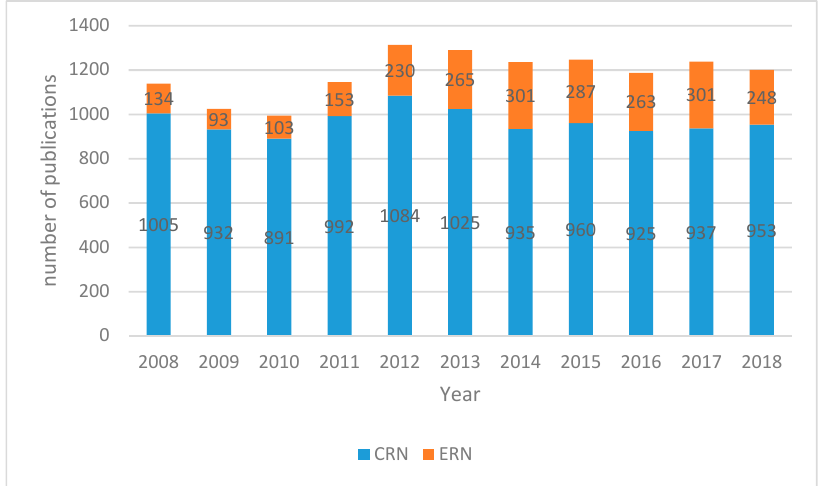
Figure 1. A comparison between the annual publication number of CRNs vs. ERNs (2008–2018). Total number of papers = 12717; total number of papers on CRNs = 10339; total number of papers on ERNs = 2378. Table 6. Annual publications discussing CRNs (2008–2018).